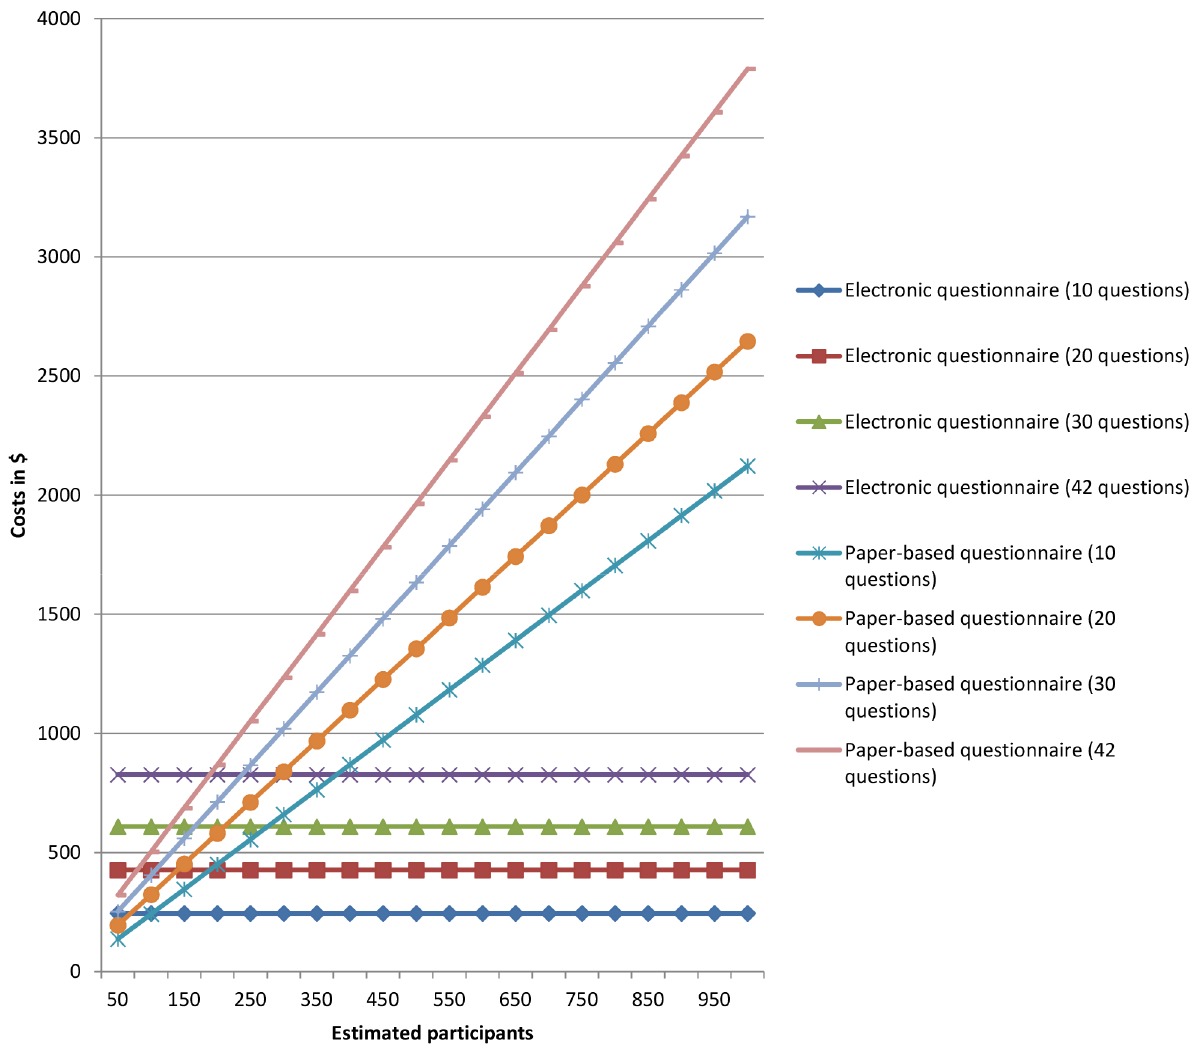
Figure 1. Estimated costs for electronic and paper-based surveys with different cohort sizes and numbers of questions based on the surveys E 1 (centralized e-mails), H 1 (homepage link), and P 1 (paper-based questionnaires).